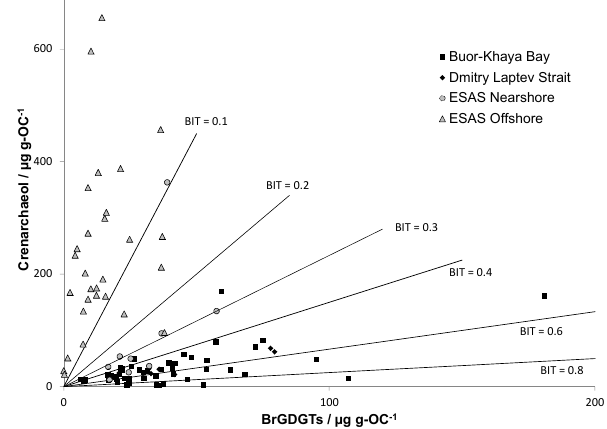
Figure 4. Plot of crenarchaeol vs. brGDGT concentration. Nearshore samples from the Buor-Khaya Bay, DLS and nearshore ( < 150km from river mouths) ESAS have low crenarchaol con- centrations. Offshore ESAS samples ( > 150km from river mouths) have high crenarchaeol concentrations. Labelled contours show the BIT index